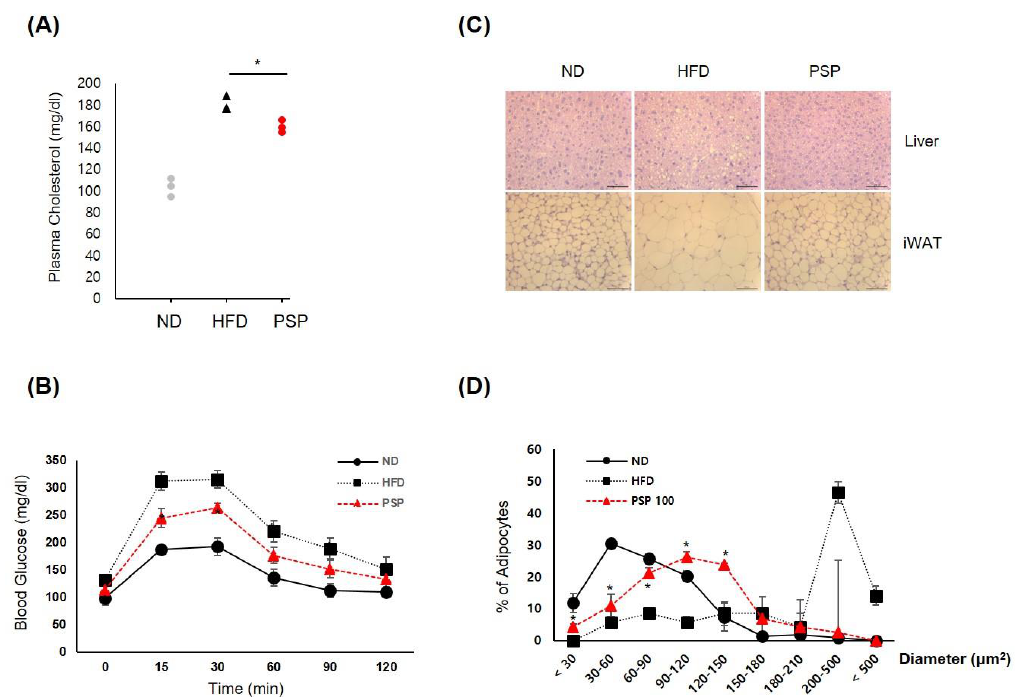
Figure 2. Effects of PSP on HFD-induced metabolic abnormalities: ( A ) The plasma CHO level of the mice in the indicated groups ( n = 3/group). ( B ) Glucose tolerance test of the mice in the indicated groups. ( C , D ) The representative images of liver (upper) and iWAT tissues (lower) were stained with H&E ( n = 3/group) ( C ). Adipocyte size was measured using the ImageJ software. ( D ) The density curves of the ND, HFD, and PSP groups. * p < 0.05, the significance of the difference from the HFD group. The bar graphs display the mean ± SD of the three mice per group.